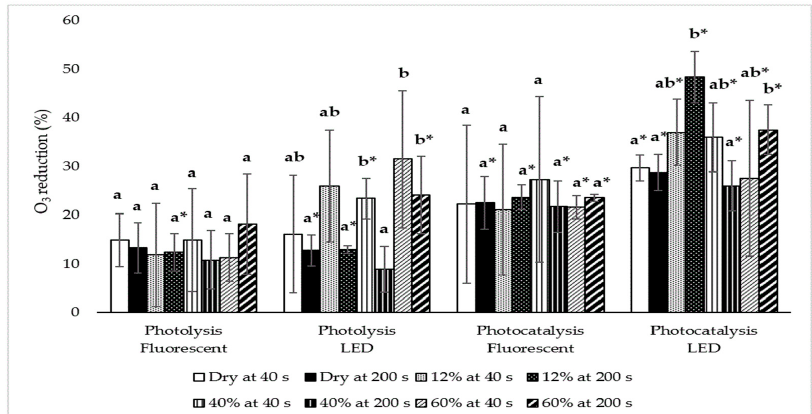
Figure 16. Comparison of O 3 mitigation under di ff erent relative humidity and treatment time. Superscript (*) signifies a statistical di ff erence compared to the control ( p < 0.05), and the di ff erent characters (a, b) signify a statistical di ff erence between treatments associated with a lamp type ( p < 0.05). Error bars signify ± standard deviation.